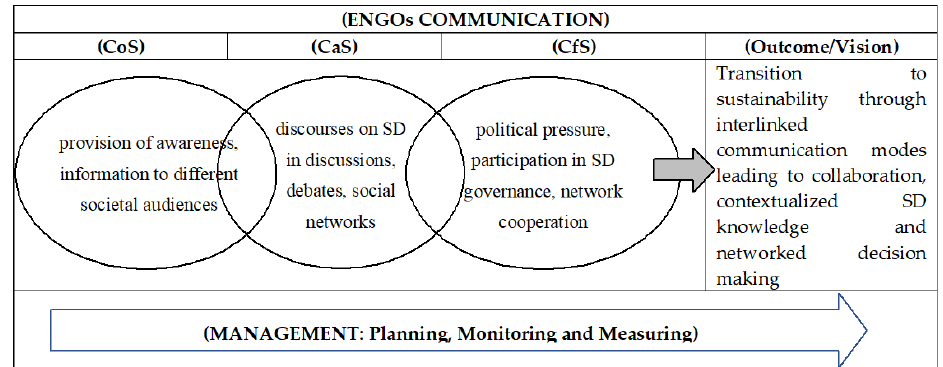
Figure 1. ENGOs effective communication management towards sustainability.